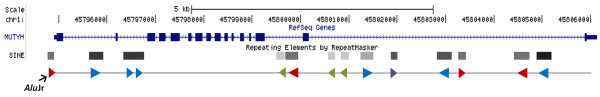
Short interspersed nucleotide element (SINE) content of the MUTYH genomic region (chr1:45794343-45806142) (data from UCSC database and RepeatMasker). A region of 11.8 kb is shown, extending 571 bp downstream of the MUTYH gene. Vertical bars in the genomic sequence indicate exons. The direction of the arrowheads denotes the orientation of the SINE repeat elements and each family is represented by a different color (Red: AluJ, Blue: AluS, Green: MIR, Purple: FLAM_C). The black arrow indicates the AluJr element involved in the distal breakpoint; no repetitive element is present on the proximal breakpoint.